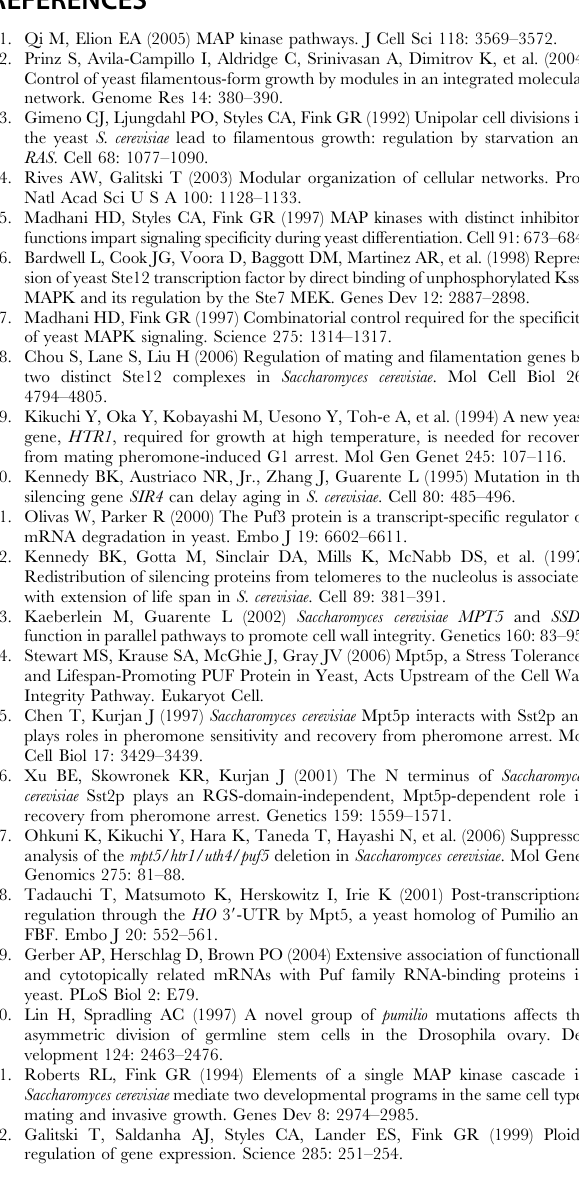
Figure S2 Phosphorylation of Tec1 and Ste7 in mpt5 D strains.